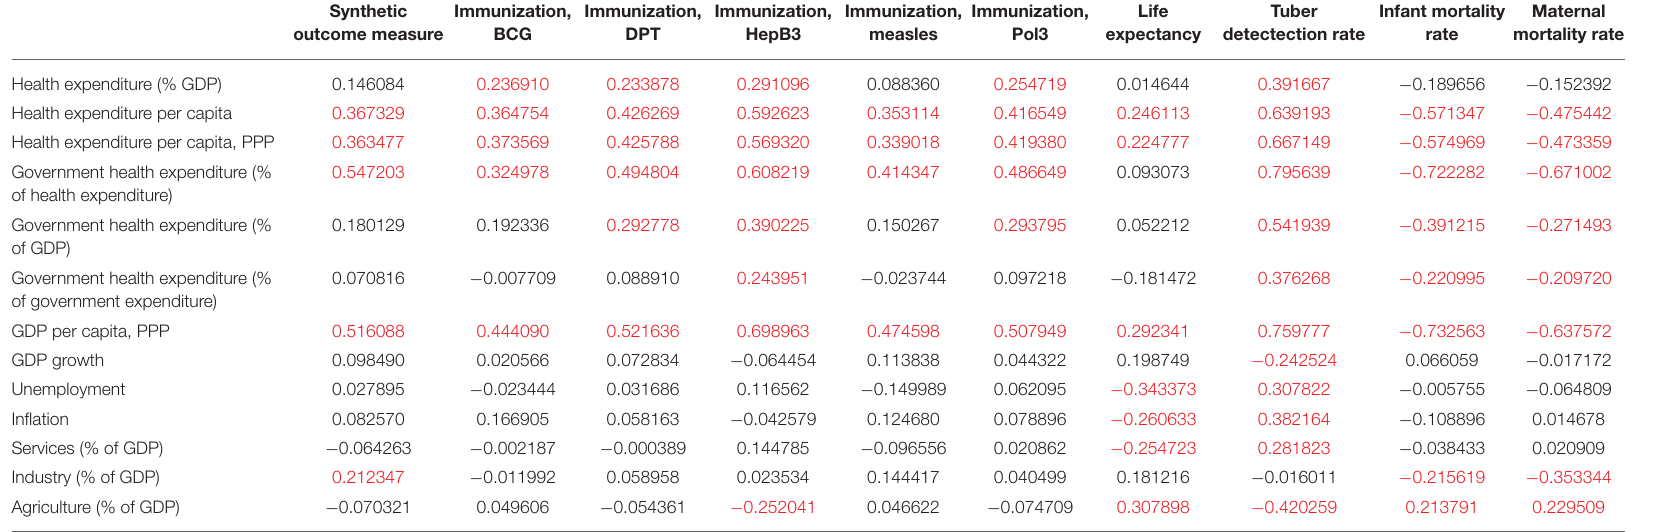
TABLE 2 | Correlation between health system performance and economic factors.